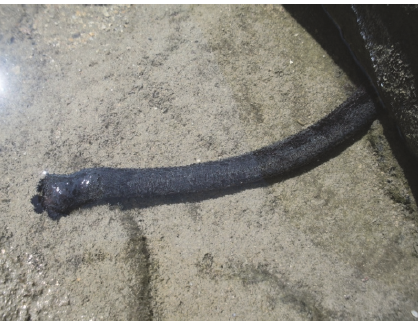
Figure 5: Population estimate of Holothuria leucospilota from every station.